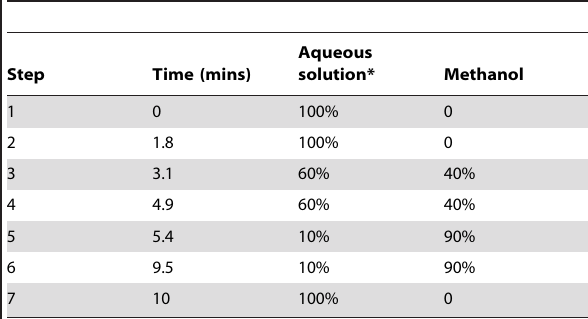
Table 2. Mobile phase gradient used for the separation of DXP intermediates in the UPLC